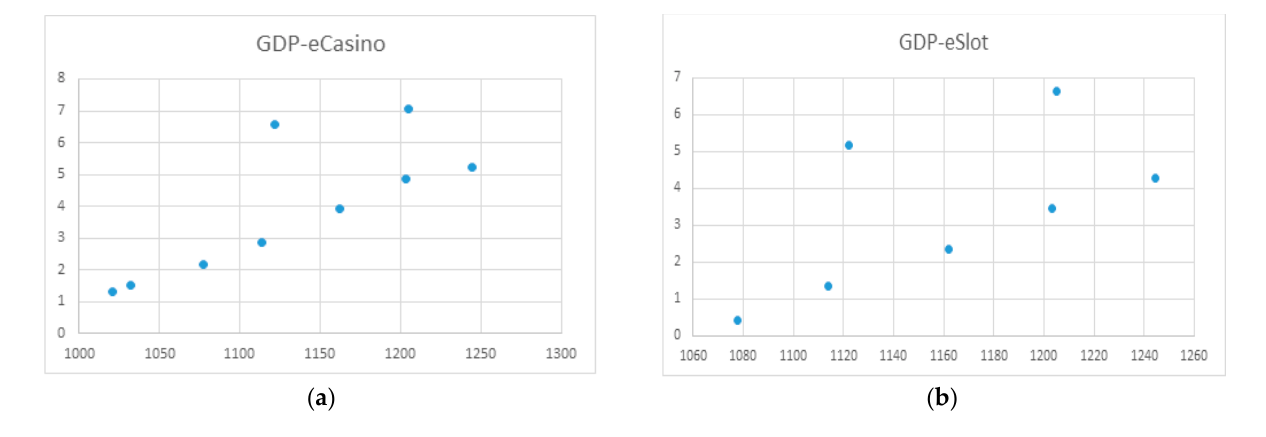
Figure 9. ( a ) Regression function between GDP and online casino spending; ( b ) Regression function